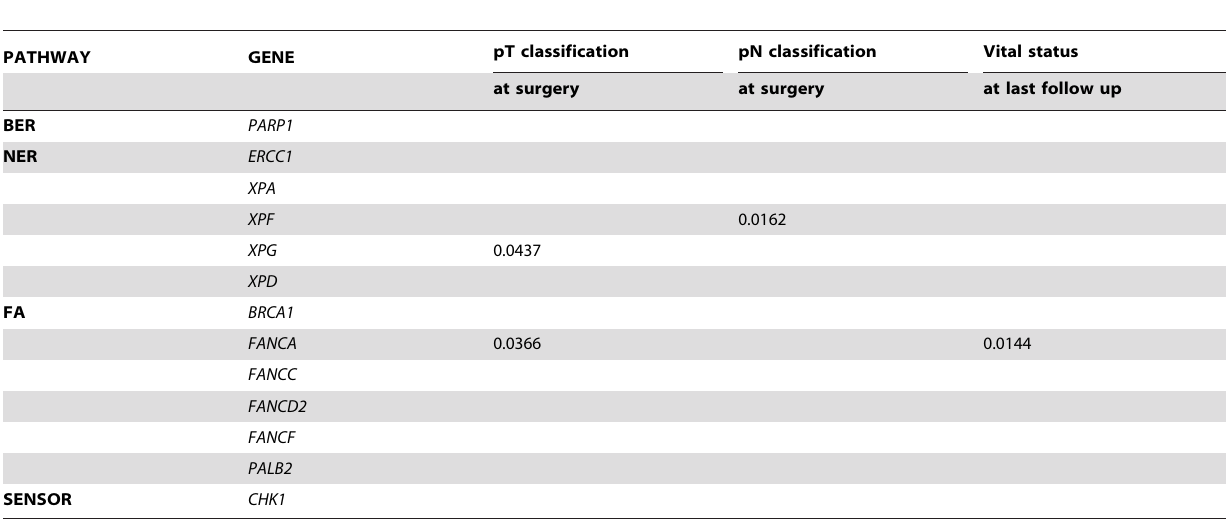
Table 4. Significant p values for the association between gene expression and clinic-pathological characteristics of triple negative breast cancer patients (univariate analysis, categorization based on tertiles).